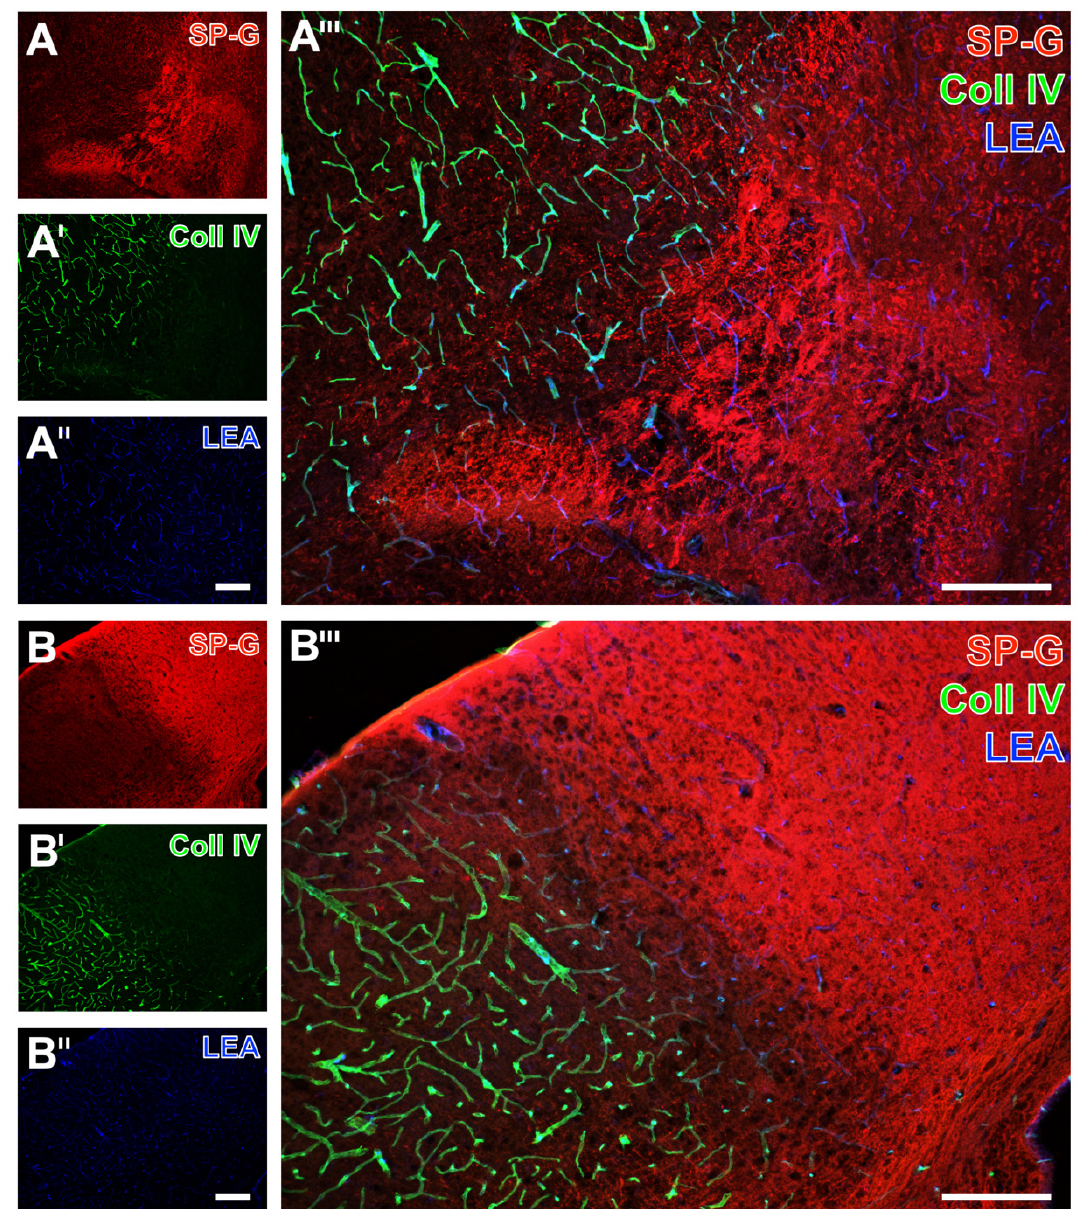
Figure 2. Regional associations of surfactant protein-G (SP-G) and vascular elements after 24 h of ischemia in mice depending on brain regions. Exemplary combined fluorescence labeling of SP-G, collagen IV (Coll IV), and lectin-based visualization of the vasculature (LEA) in the affected striatum ( A – A’’’ ) and in the neocortex ( B – B’’’ ) of mice 24 h after ischemia onset. Scale bars: A’’ (also valid for A and A’ ) = 200 μ m, A’’’ = 200 μ m, B’’ (also valid for B and B’ ) = 200 μ m, B’’’ = 200 μ m.